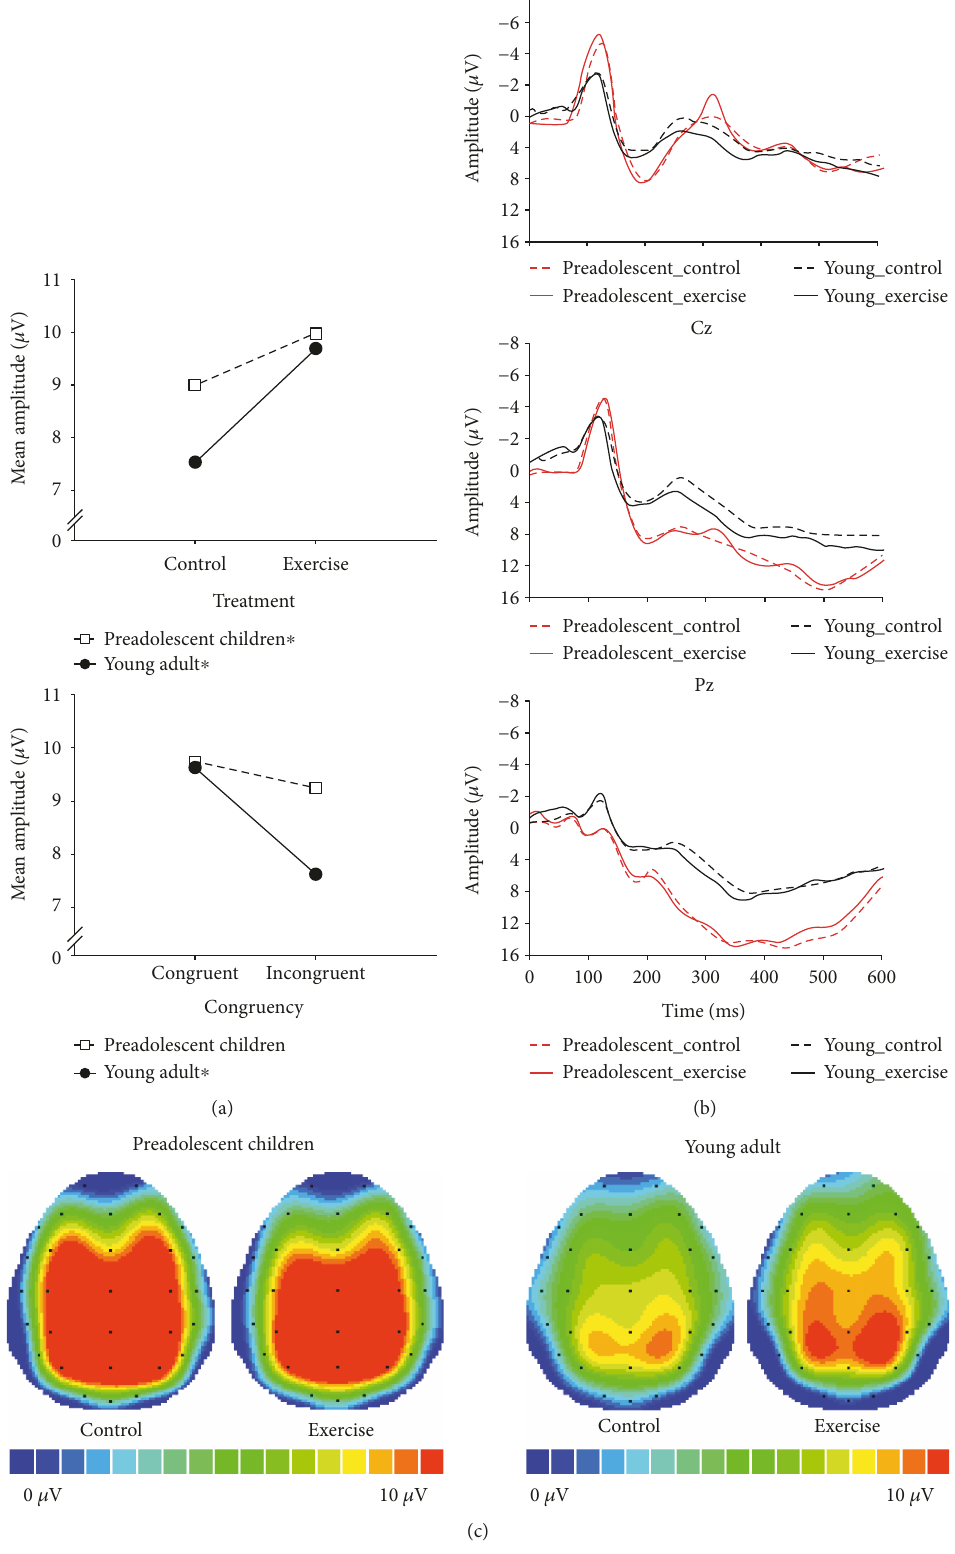
Figure 2: (a) Main e ff ect of treatment and the interaction e ff ect of congruency and group. (b) Stimulus-locked grand-average waveform at Fz, Cz, and Pz, collapsed across congruency in treatments and groups. (c) Topographic scalp distribution of the P3 amplitude collapsed across congruency in treatments and groups. ∗ Signi fi cant di ff erence within a group ( p < 0 05